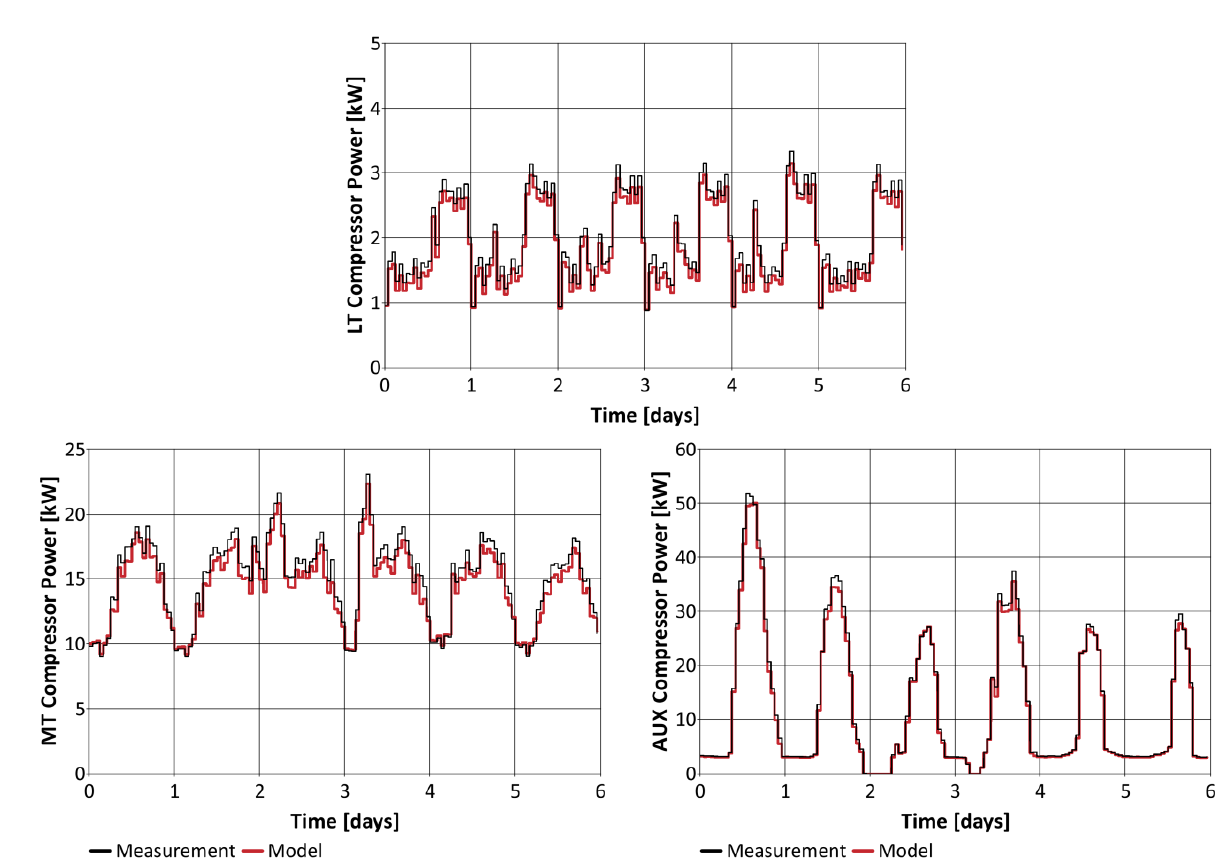
Figure 7. Validation results for the compressor modeling approach; comparison between measured (black) vs. calculated (red) compressor power values in kW for LT, MT, and AUX compressors.